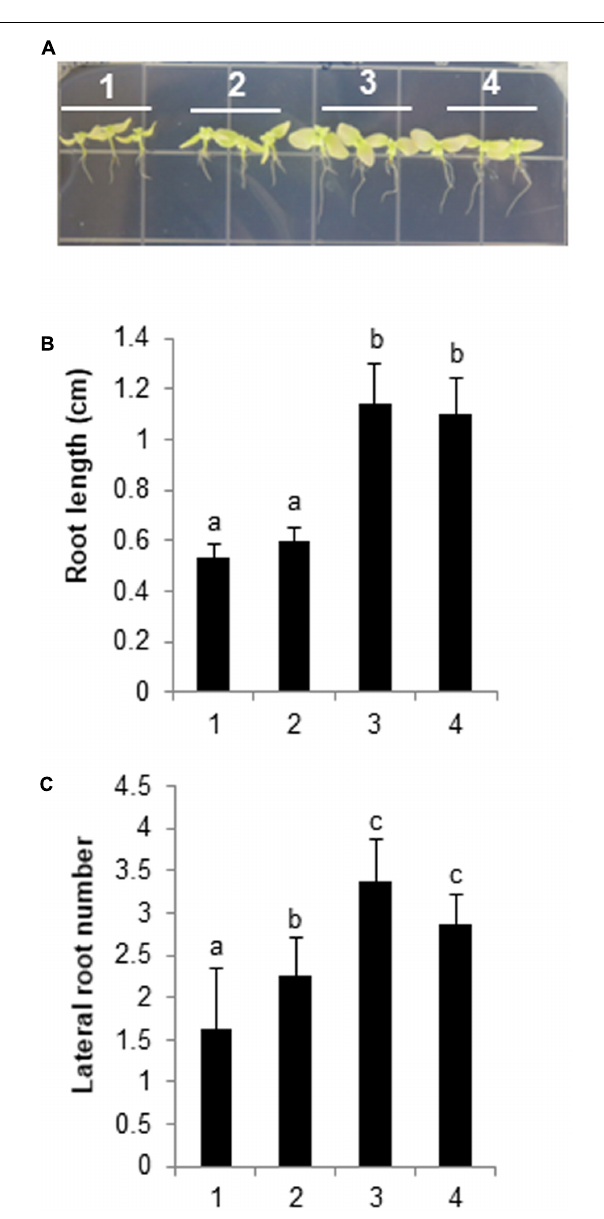
FIGURE 8 | Biological effects of GLV treatments on N. benthamiana plants. Two-week-old seedlings were pretreated with 2 µ l 0.1 M GLV or DCM (control) for 1 h. The seedlings were then transferred to Murashige and Skoog agar medium containing 300 mM NaCl, and plants were allowed to grow for an additional 4 weeks. The plants were photographed at the conclusion of the salt treatment. (A) (1) DCM; (2) E -2-hexenal; (3) Z -3-hexenol; (4) Z -3-hexenyl acetate. (B) Analysis of root length and (C) number of lateral roots. The data for three biological replicates were averaged. Different letters represent significant differences at P < 0.05 ( t -test). Bars indicate the standard deviation of the mean. to drought and cold stresses, and the RD29B promoter is highly responsive to salt stress (Msanne et al.,